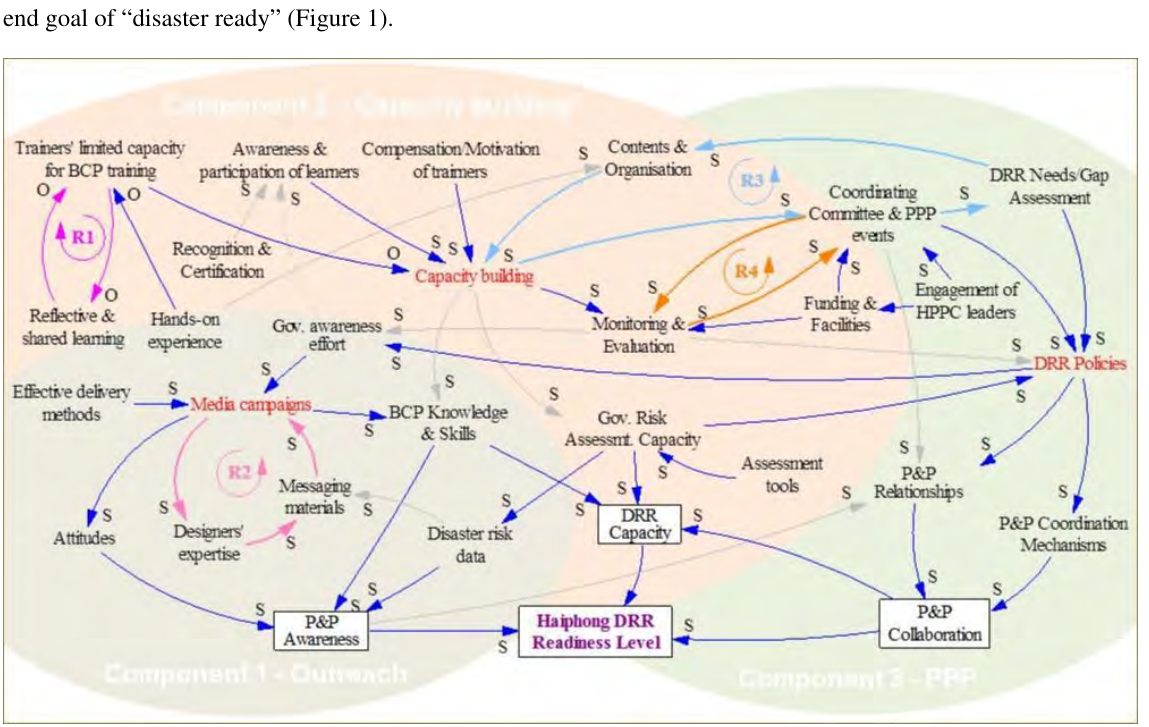
Figure 1. Casual loop diagram (CLD) modeling for understanding thecurrent situation of disaster risk management